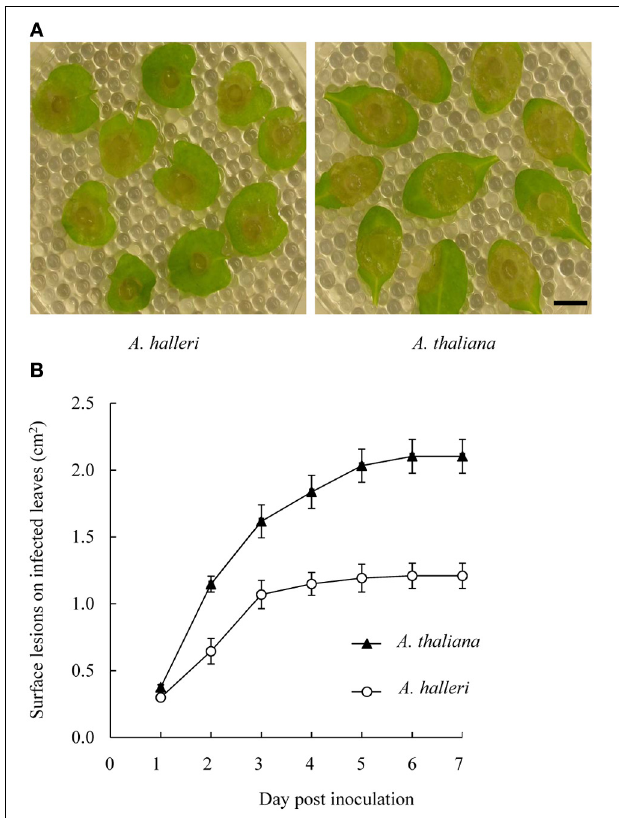
FIGURE 5 | Disease development on A. thaliana and A. halleri leaves following B. cinerea inoculation. Leaves were inoculated with 3mm diameter mycelium plugs of B. cinerea (A) Spreading lesions on A. halleri leaves (left) and on A. thaliana leaves (right) were photographed 3days post-inoculation (dpi). Bar = 1cm. (B) Surface lesions on infected leaves were measured daily up to 7dpi. For each genotype, mean lesion surface values were determined from ∼ 20 inoculated leaves derived from 6 plants grown in soil. Error bars represent standard deviations. A Kruskal-Wallis statistical test was performed and all A. thaliana measurement values showed significant differences ( p < 0 . 005) with A. halleri measurement values from